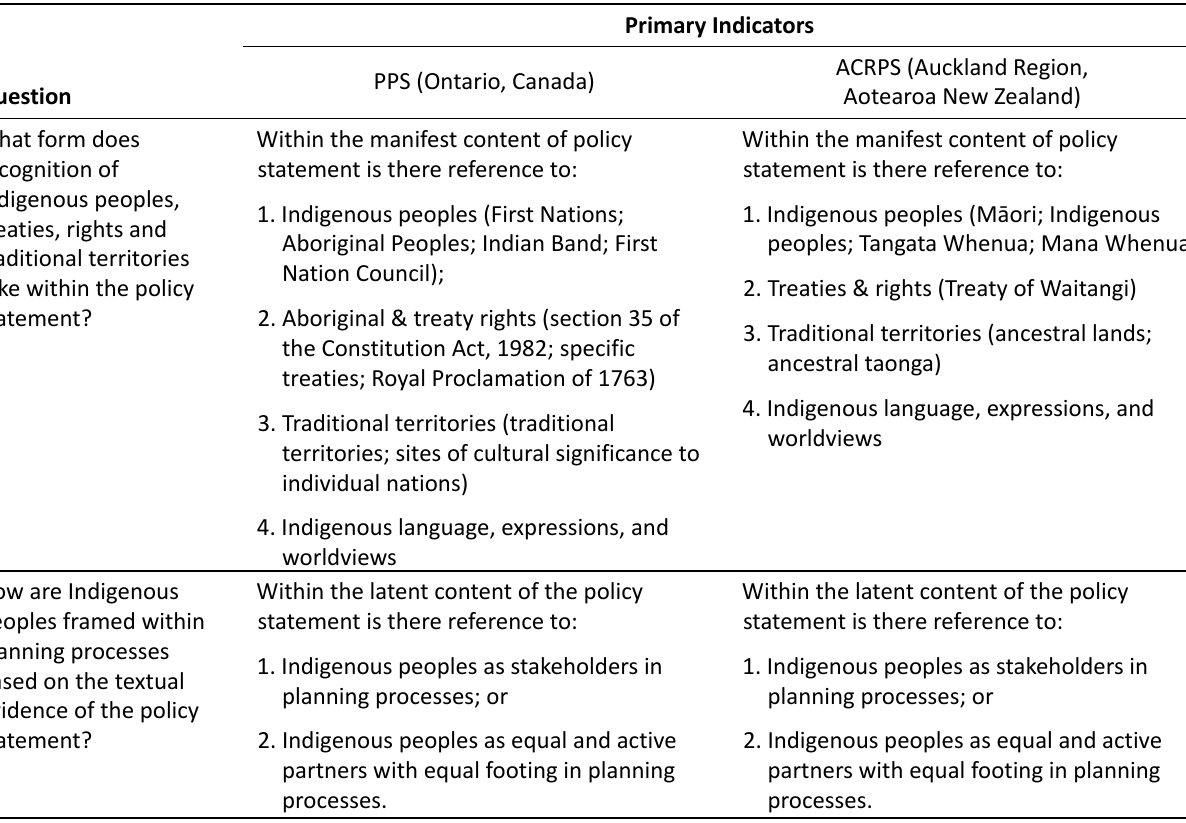
Table 2. Key aspects to Recognition in reference to the Ontario Provincial Policy Statement and the Auckland Council Re- gional Policy Statement.